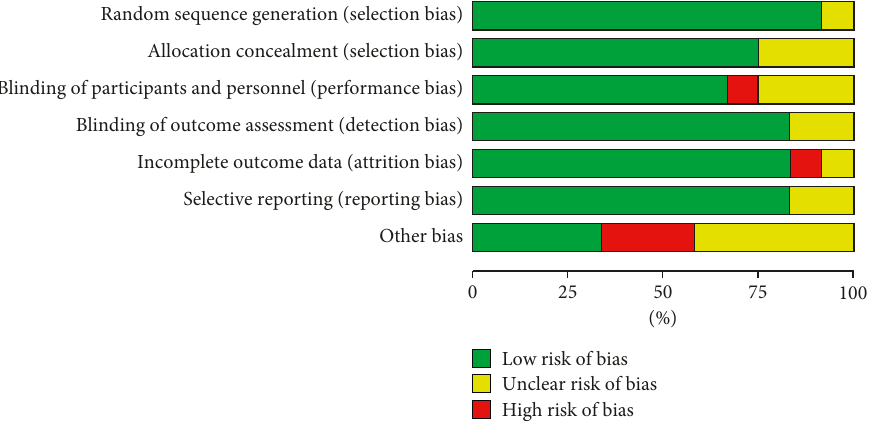
Figure 1: The risk of summary biases reported in the